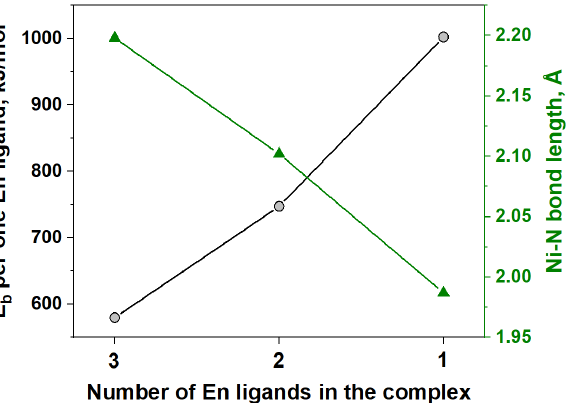
Figure 2. Ni-En bond energies (E b ) and Ni-N bond lengths for [Ni(En) n ] 2+ , where n = 1, 2, 3, calculated using DFT.